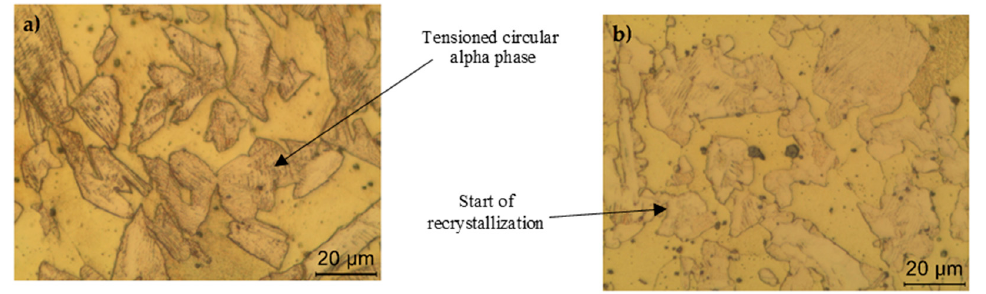
Figure 9. ( a ) Tensioned structure corresponding to the reference sample. ( b ) Beginning of the decrease in the tension in the α‐ phase at 400 °C.